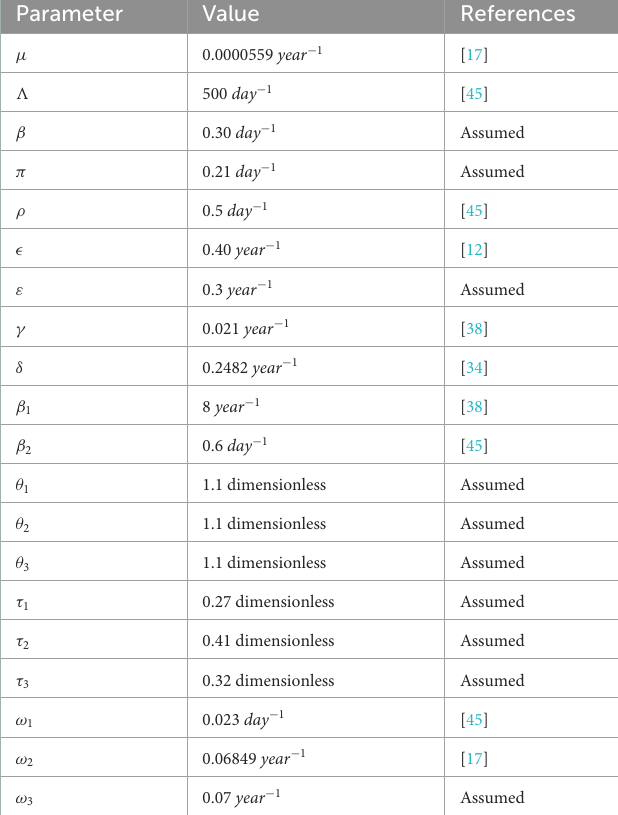
TABLE 3 Parameter values for numerical